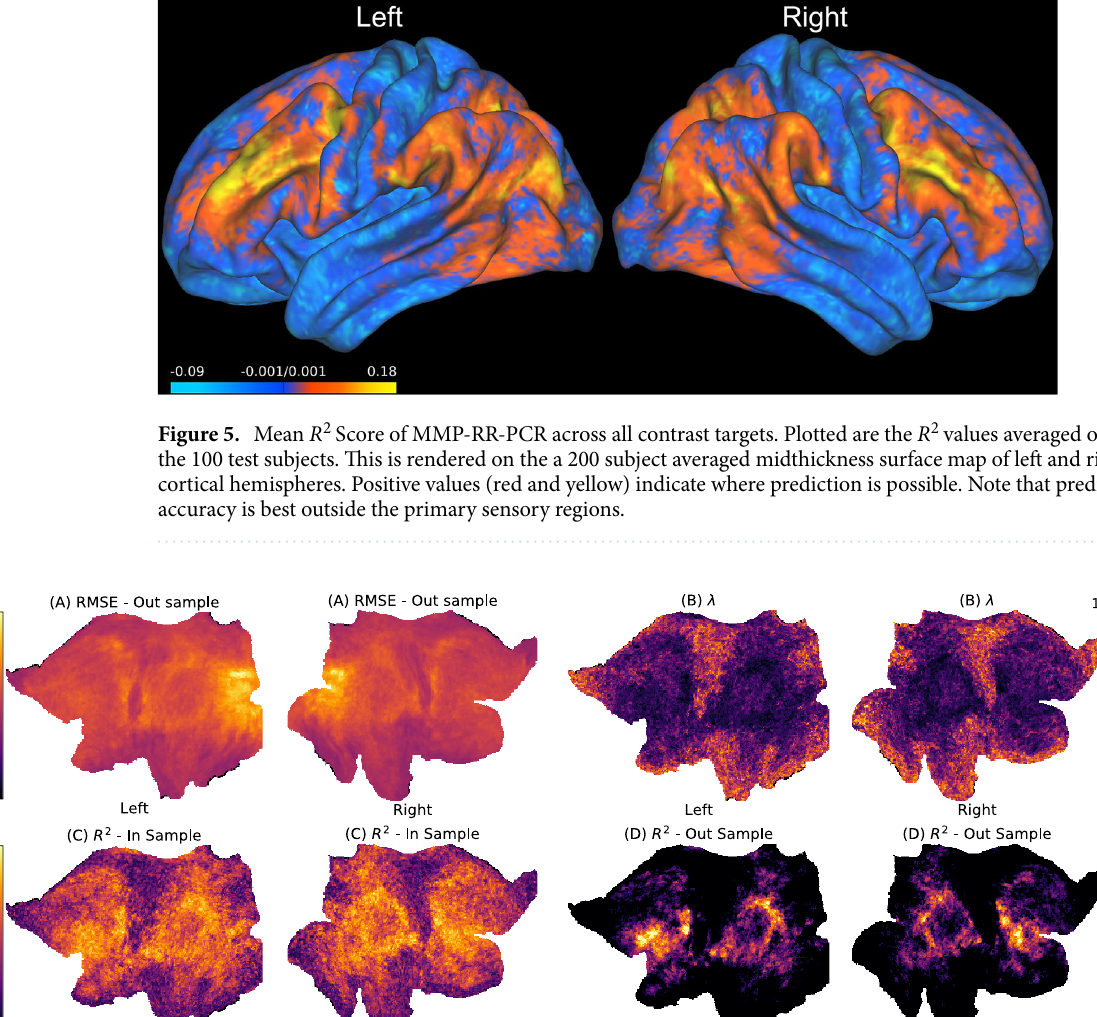
2 2 —100 train subjects ( D ) R —100 test subjects. 2 show consistent patterns between 2 ). Both vertex-